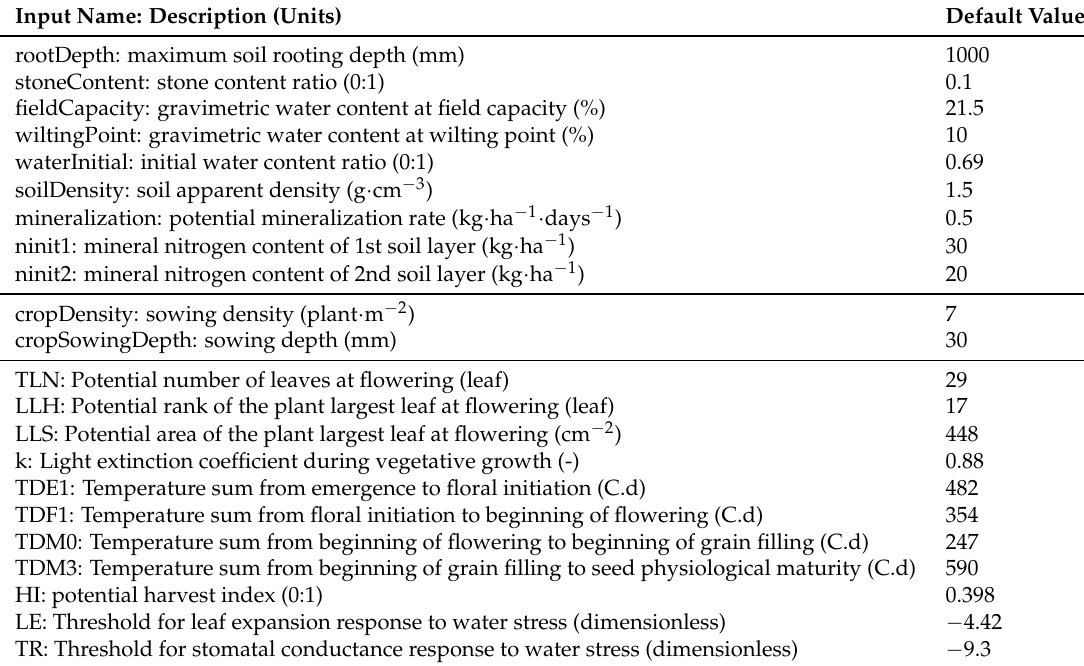
Table 2. SUNFLO scalar inputs. The first nine inputs describe soil conditions, the next 2 inputs describe management. The others describe sunflower crop